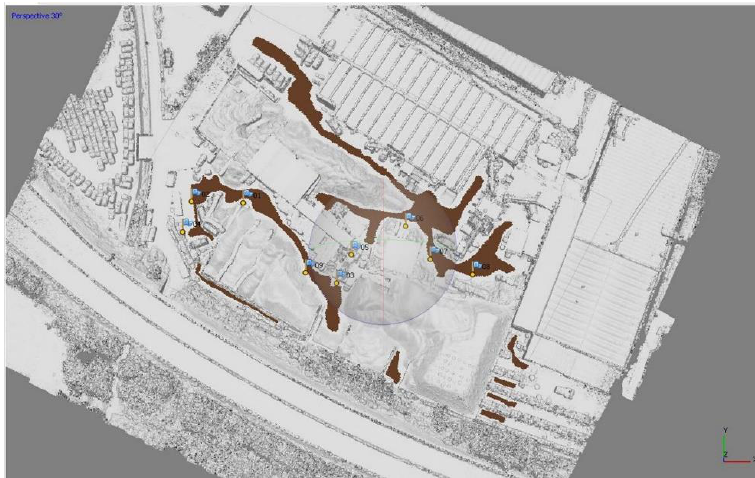
Figure 17. Manual classification of the ground in Photoscan for generating the DEM reference base.